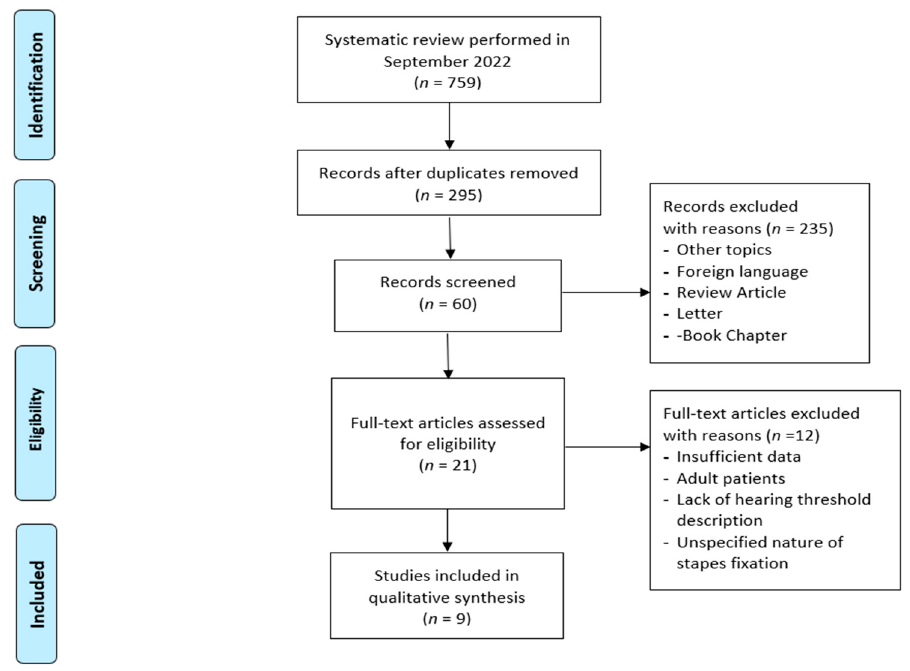
Figure 1. Literature evaluation and selection, according to PRISMA criteria (http://www.prisma- statement.org/ (last access 30 September 2022).